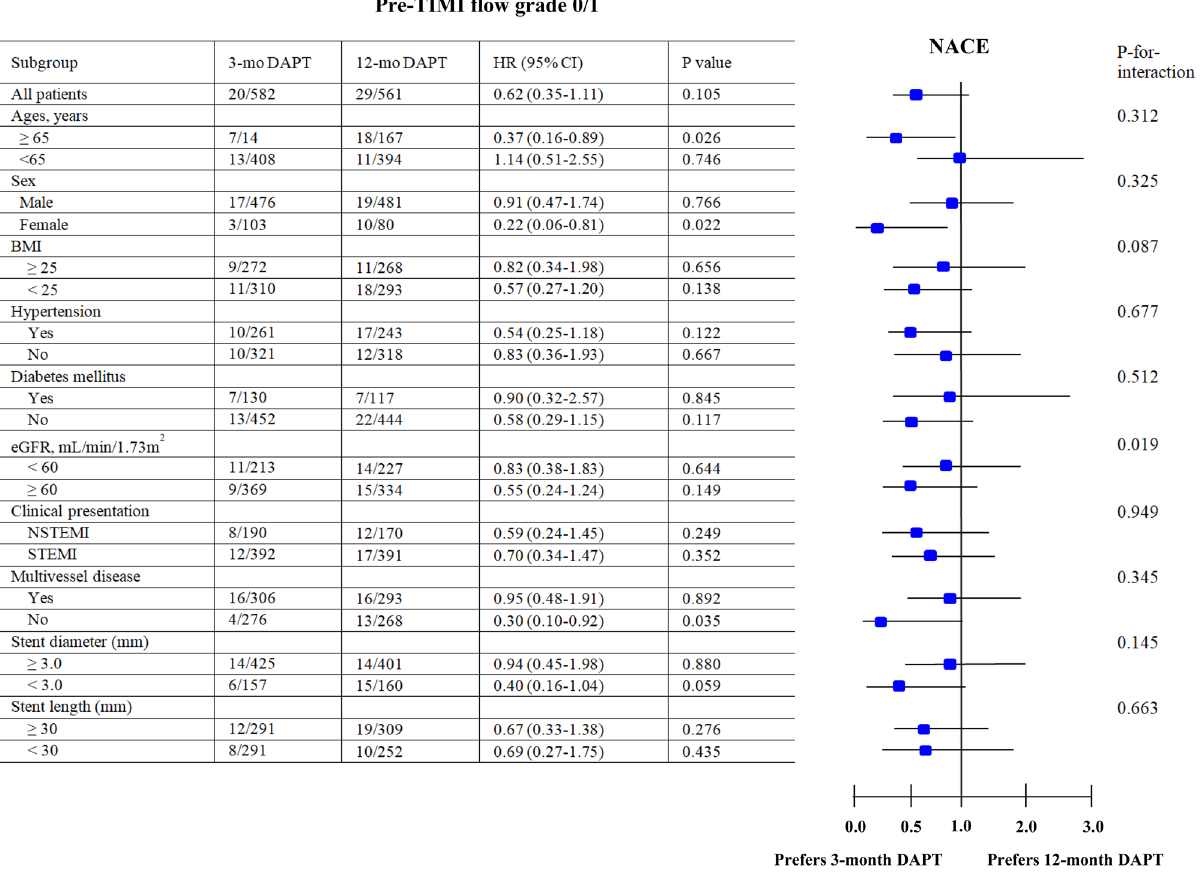
Figure 2. Subgroup analysis for NACE in pre-TIMI flow grade 0/1 group. NACE net adverse clinical event, Pre-PCI pre-percutaneous coronary intervention, TIMI Thrombolysis In Myocardial Infarction, 3-mo DAPT